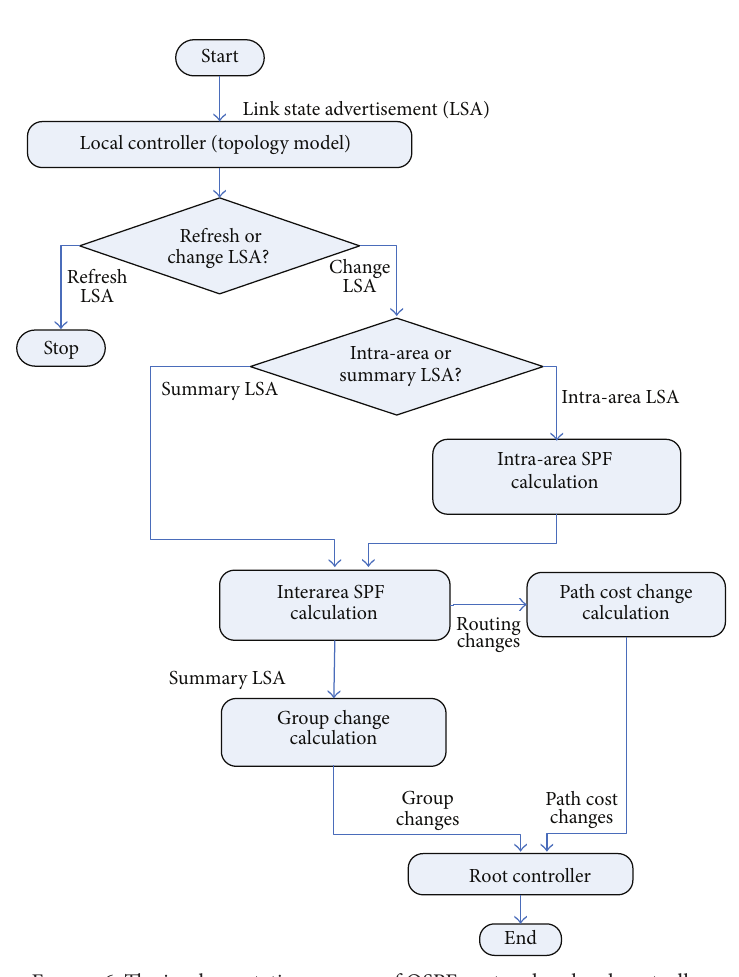
Figure 6: The implementation process of OSPF protocol on local controller.